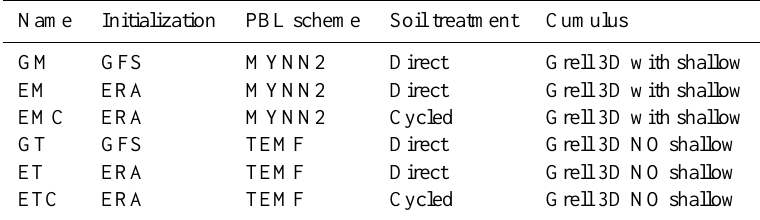
Table 1. Names and primary definitions of the six WRF configurations to be discussed.